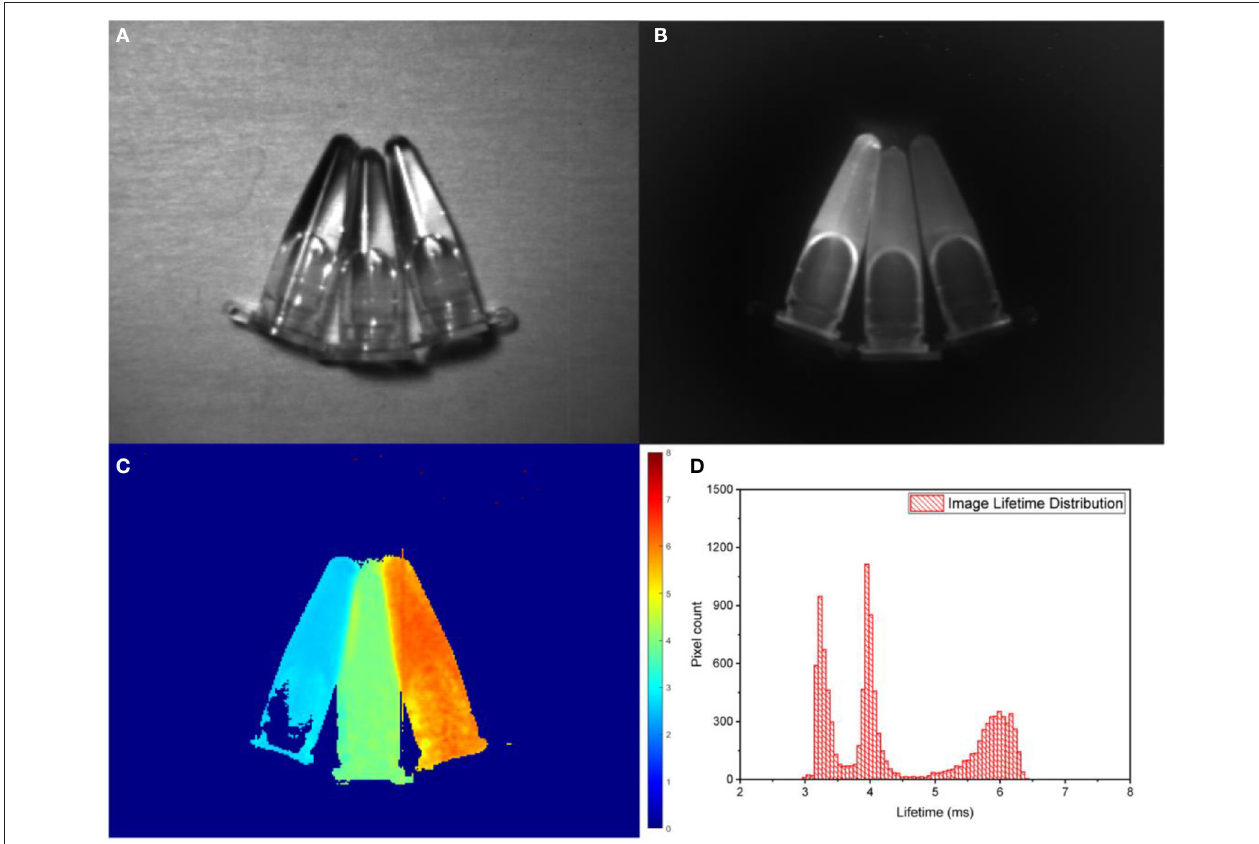
FIGURE 3 | (A) Bright-field imaging of Eppendorf tubes with NaYF 4 :20%Yb, x%Er@NaYF 4 (x = 2, 20, 80% right to left). (B) Steady-state SWIR PL imaging of Eppendorf tubes with RENPs suspensions acquired by the SWIR camera with 975-nm excitation and 1,200-nm long-pass filter. (C,D) PL lifetime image obtained using RLD approach and corresponding lifetime